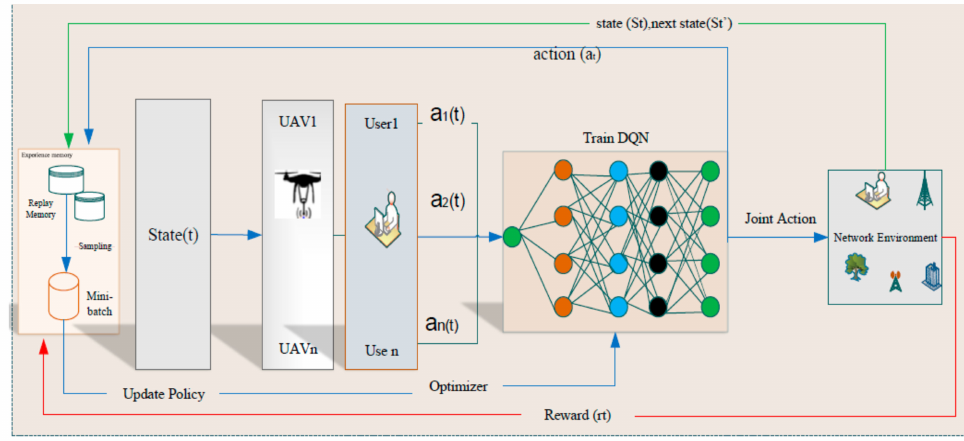
Figure 5. An illustration of multi-agent framework for proposed DRL-based RM